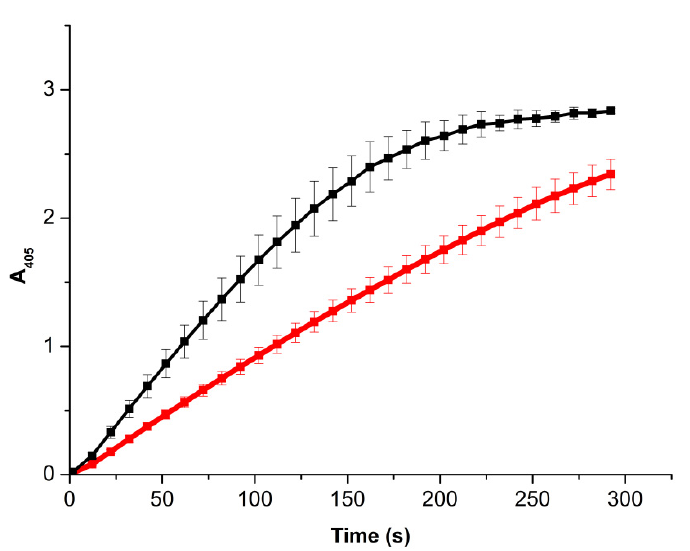
Figure 5. Results of spectrophotometry-based estimation of HRP enzymatic activity using a standard assay with ABTS. Typical time dependencies of the absorbance at 405 nm obtained for the HRP solution irradiated in PEMF (red curve), and for the control HRP solution (black curve). Experimental conditions: HRP:ABTS:H 2 O 2 = 10 − 9 M:0.3 mM:2.5 mM. T = 23 °C.